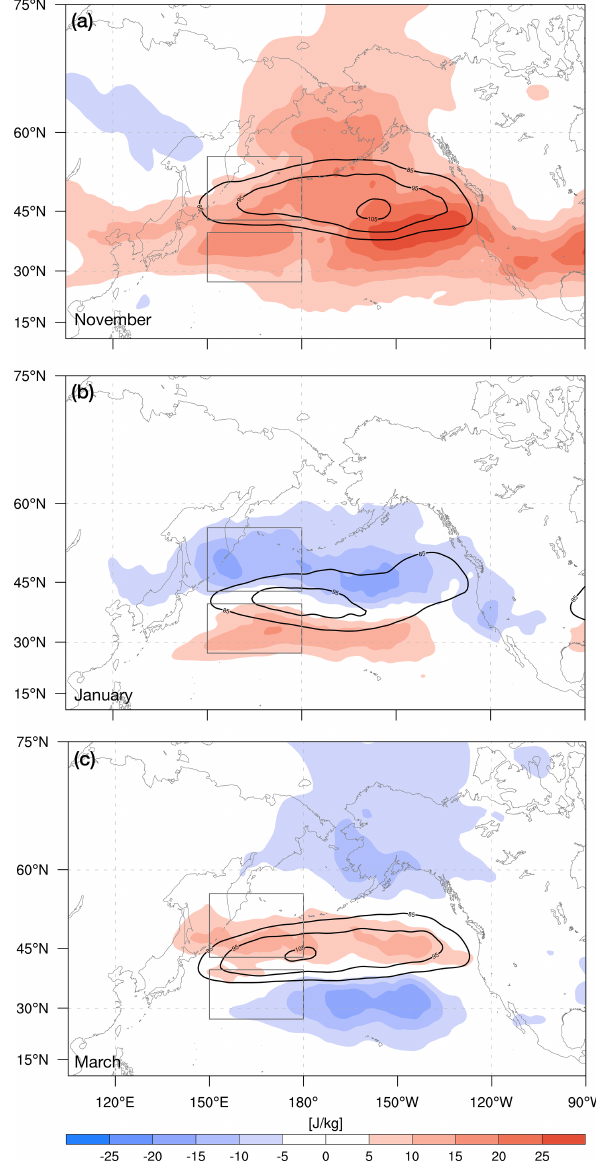
Figure 1. Mean EKE at the 500hPa level (black contours at 85, 95, and 105Jkg − 1 ) and corresponding change relative to the corre- sponding previous month (color shading) for (a) November, (b) Jan- uary, and (c) March. Additionally shown are two target regions (gray boxes) that are used for the detailed diagnostics of surface- cyclone tracks throughout this